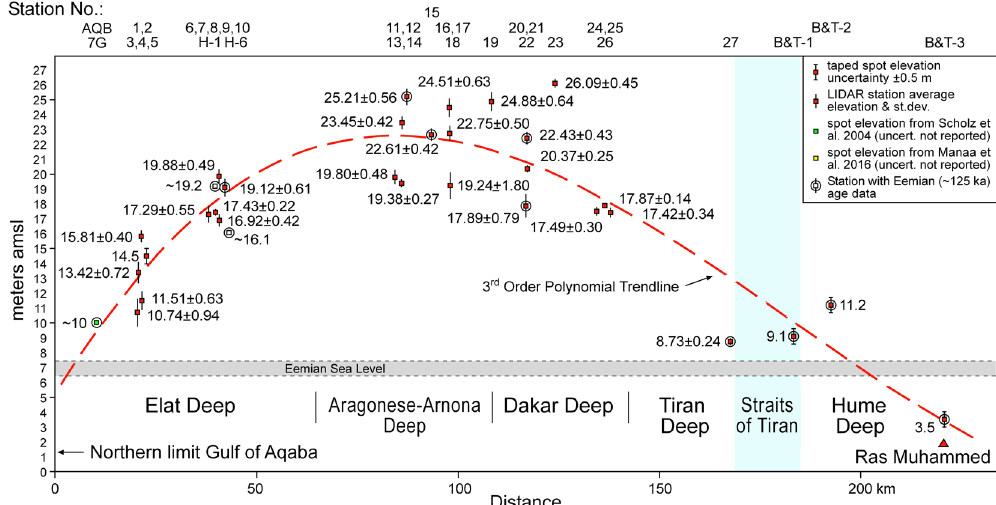
Figure 7. Elevation profile connecting the station locations of Fig. 3 (see also Table 1). All elevations are relative to local sea level without a tidal correction. Dashed curved line is a 3 rd order best-fit polynomial trendline. Elevations are for the top of the terrace. Vertical bars give uncertainty of elevation measurements (standard deviation of 10 measurements at LIDAR stations; 0.5 m for taped or laser range finder stations; no error bar for sources where none was given). Stations with Uranium-series dates are shown with outer circles and are described in Table 2 or taken from the literature.